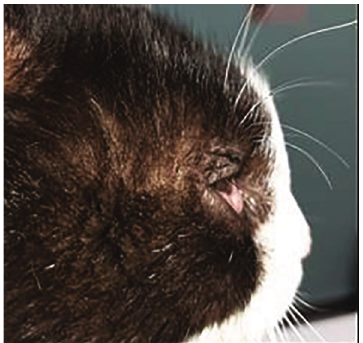
Figure 1: Swelling on the forehead is obvious along with periocular hypotrichosis.